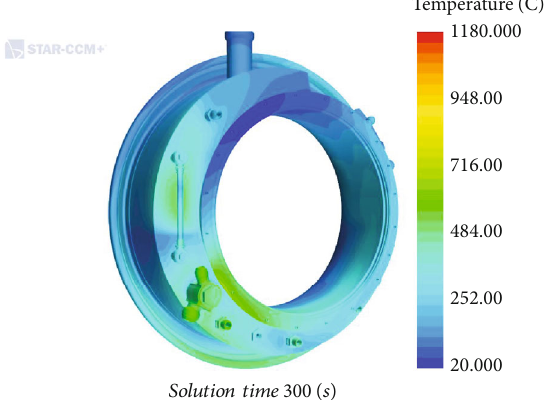
Figure 7: Temperature of the oil tank elements for oil return pipe fi re zone at t = 5